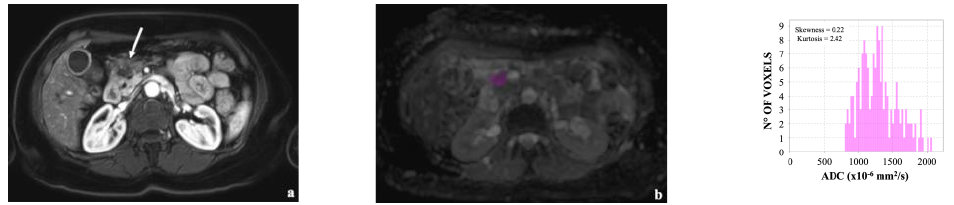
Figure 1. ( a ) 59-year-old woman with pancreatic head carcinoma (arrow); ( b ) tumor ROI is shown in purple; ( c ) histogram analysis revealed a skewness of 0.22 and kurtosis of 2.42, respectively. No metastases occurred over a 15-month follow-up after pancreaticoduodenectomy.